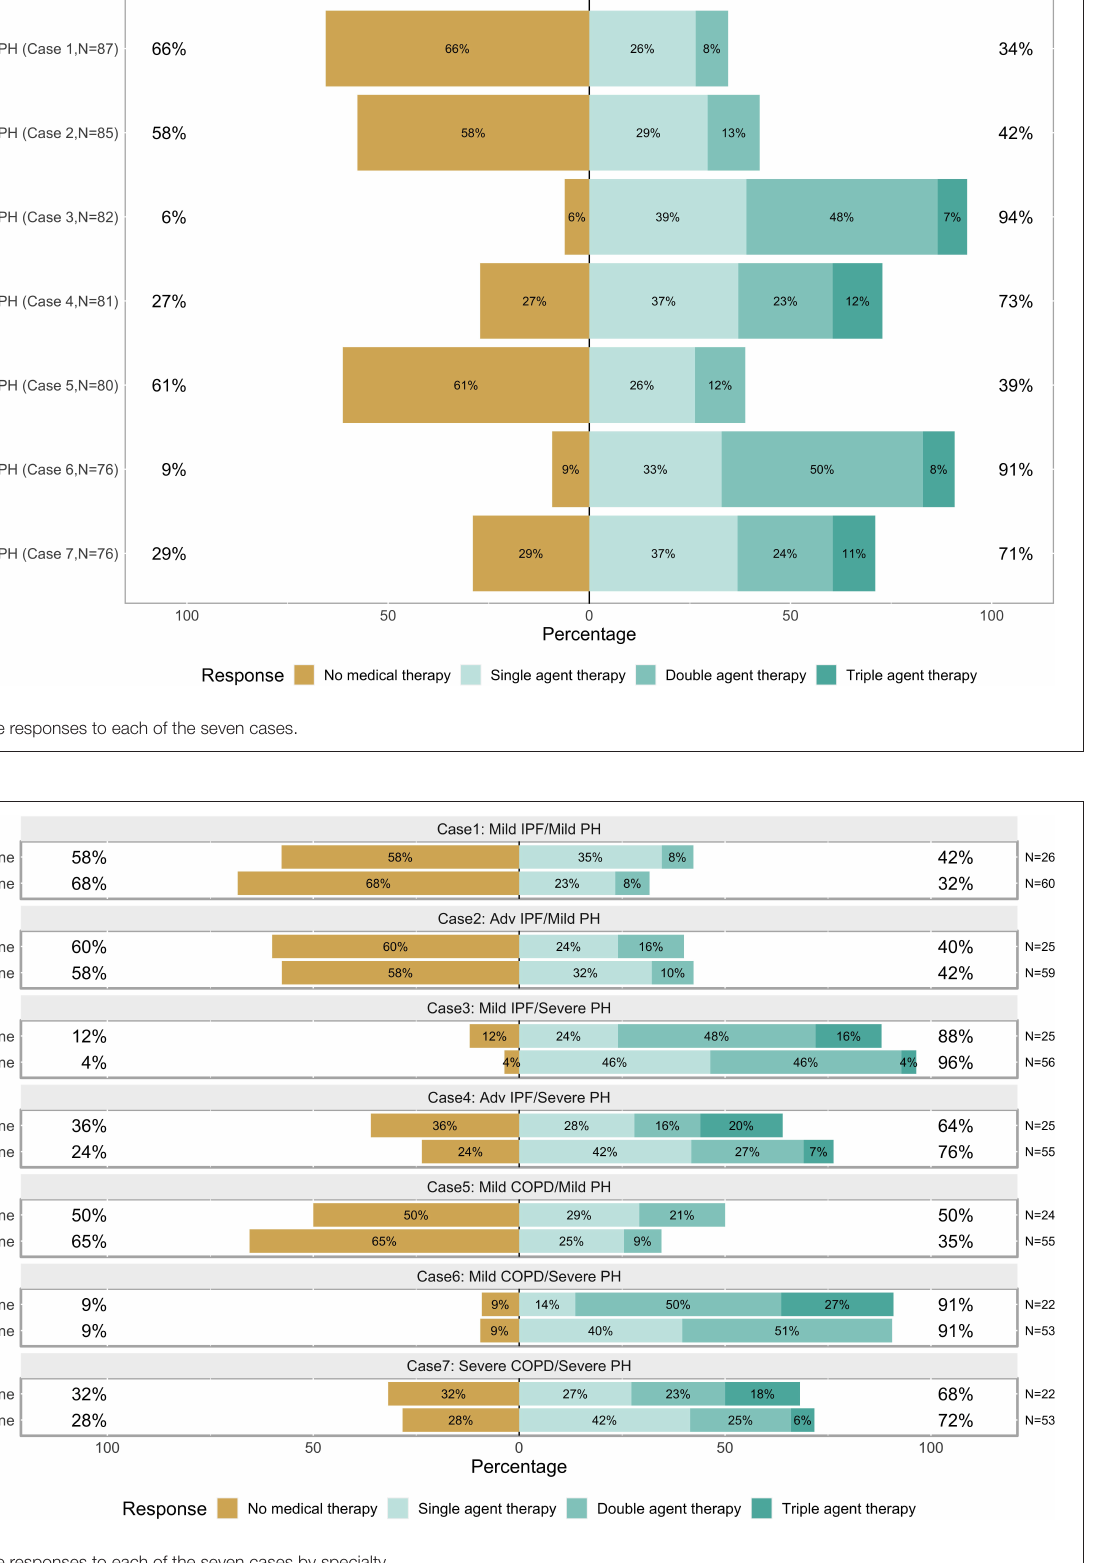
Frontiers in Medicine |